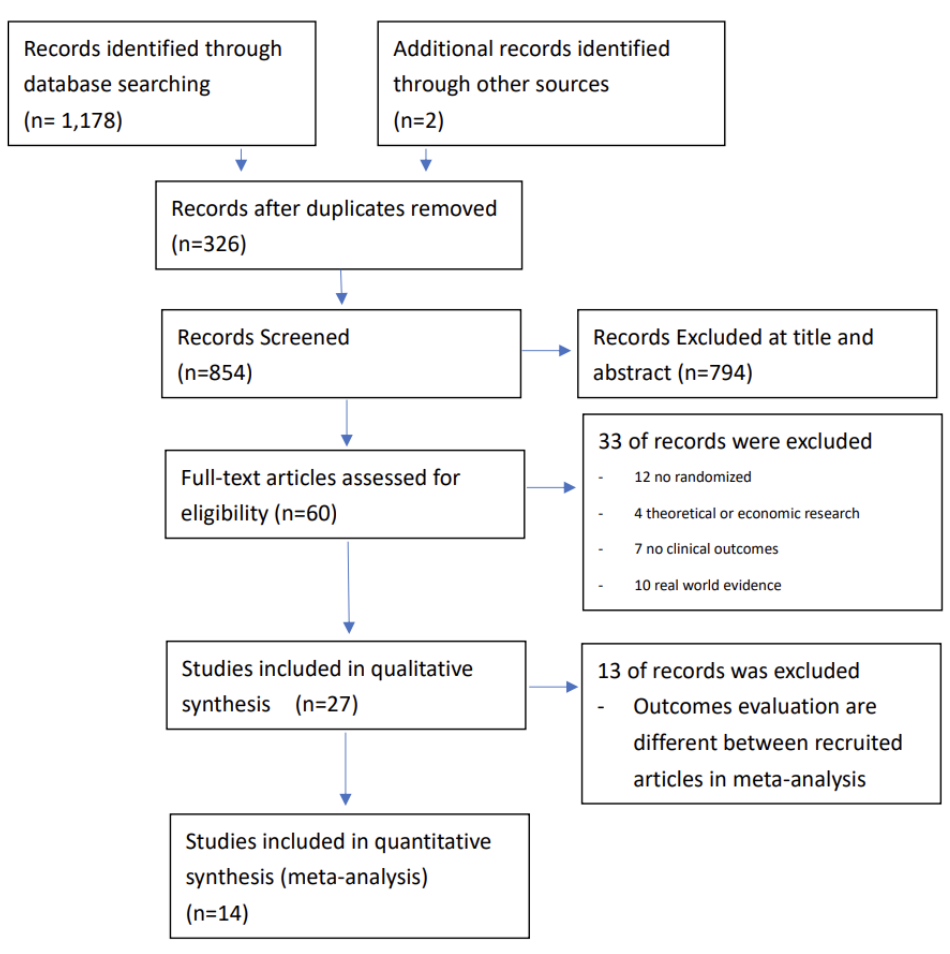
Figure 1. Flow diagram in the PRISMA format showing identification of the relevant literature.